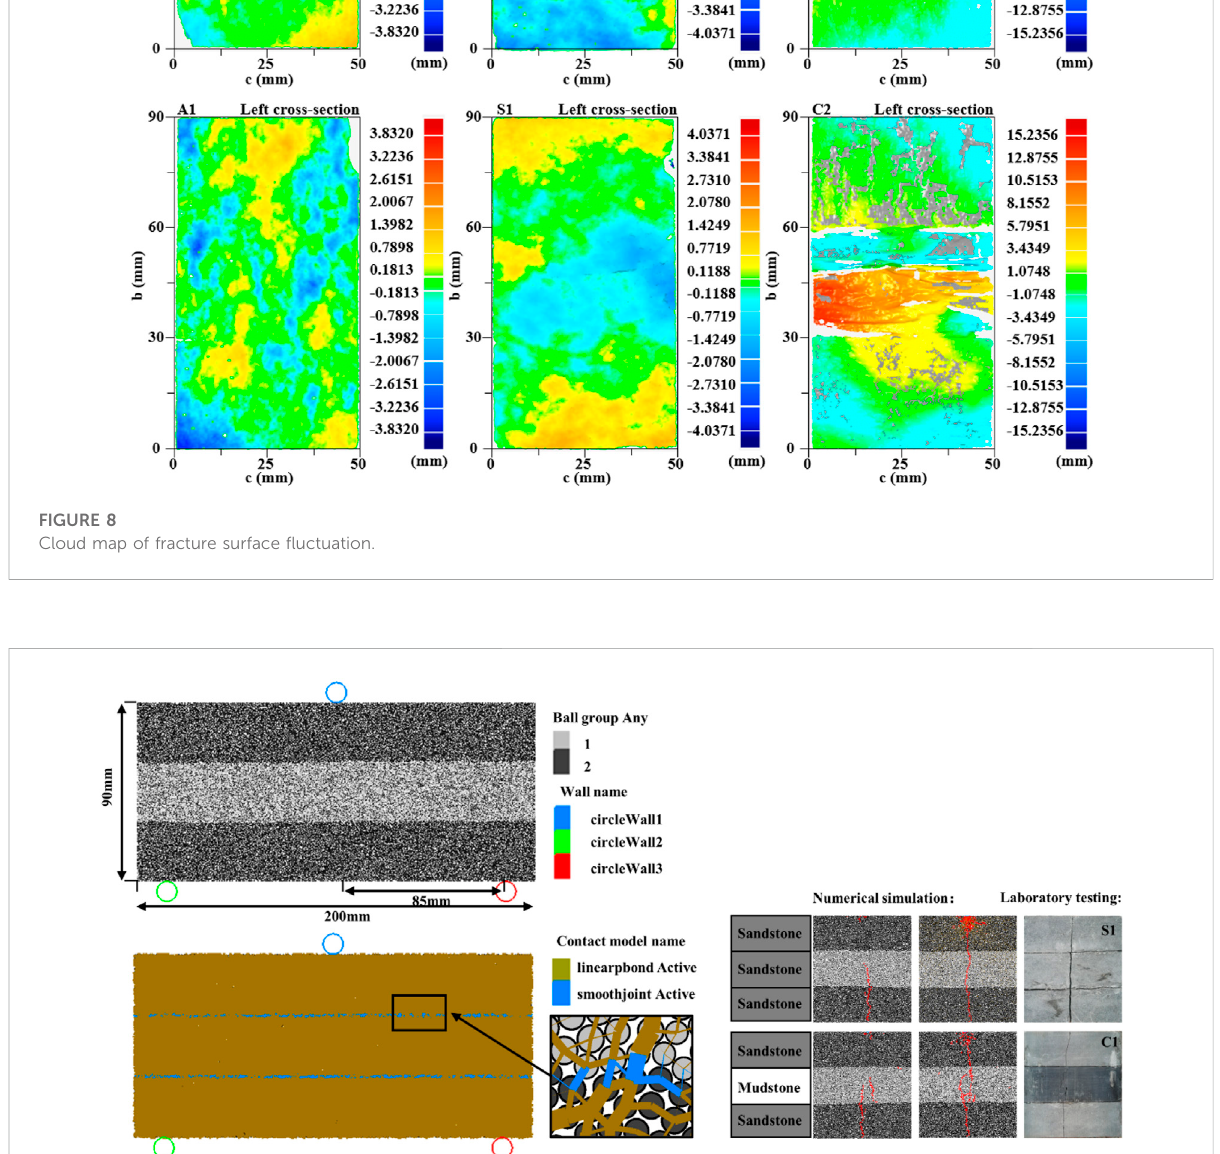
Frontiers in Earth